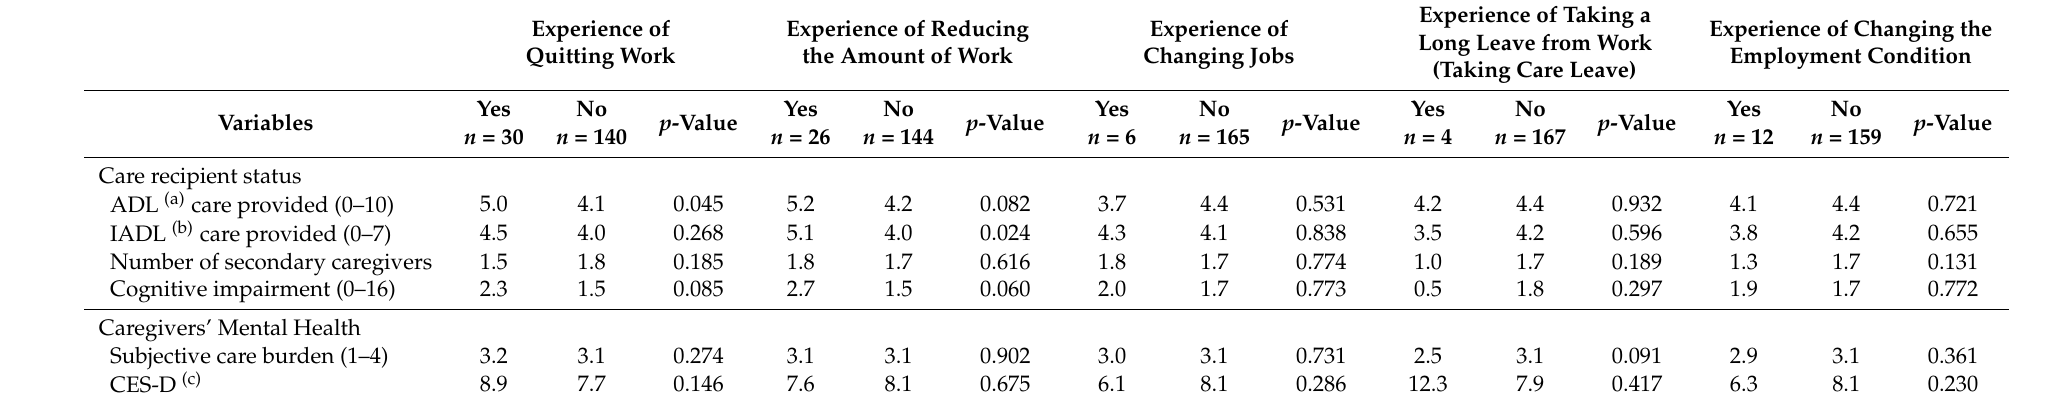
Table 2. Relationship between changes in work caused by nursing care, nursing care status, and mental health. Experience of Experience of Reducing Quitting Work the Amount of Work